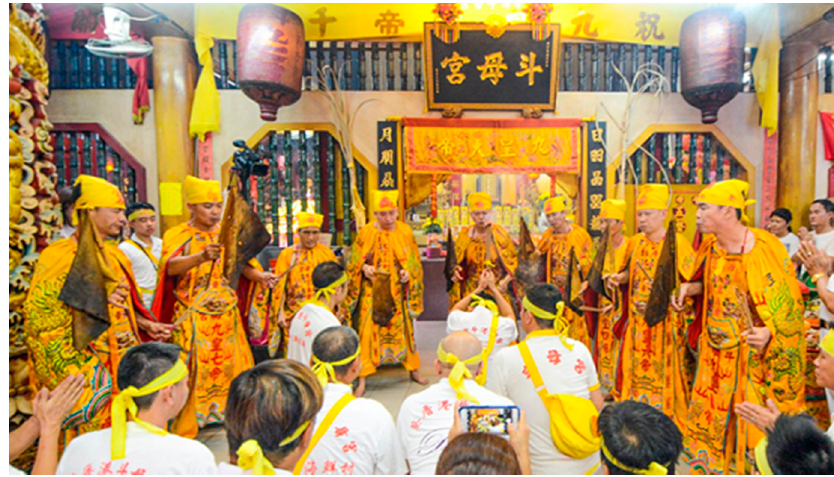
Figure 10. The Nine Spirit Mediums of the CCKDMG 20 .